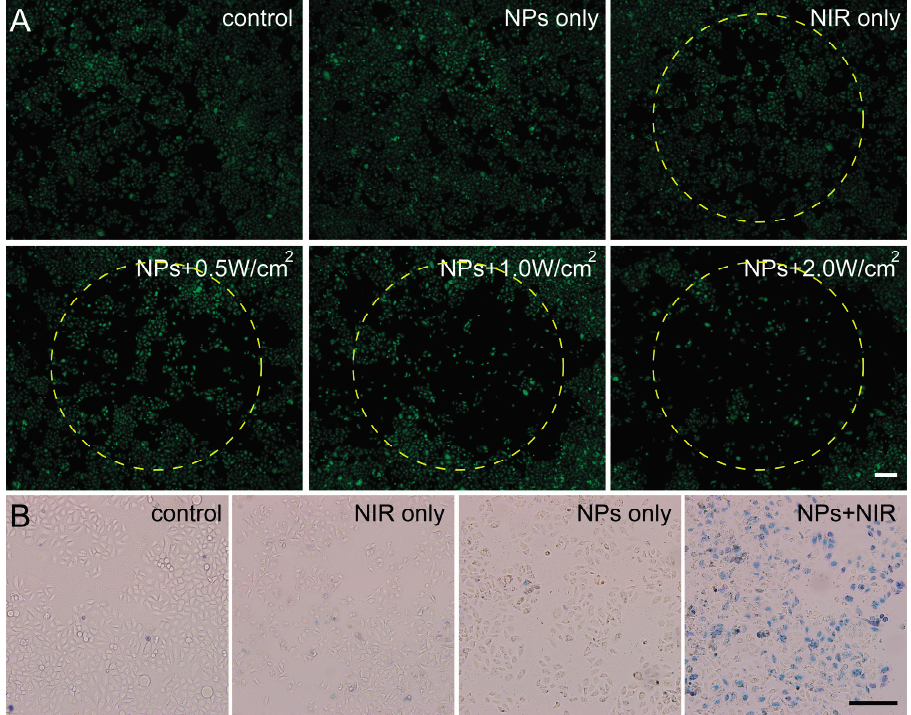
Figure 6. Fluorescence images of calcein AM stained C6 cells ( A ) and optical microscopy images of trypan blue stained C6 cells ( B ) upon different experimental conditions. All scale bars in the pictures represented 200 μ